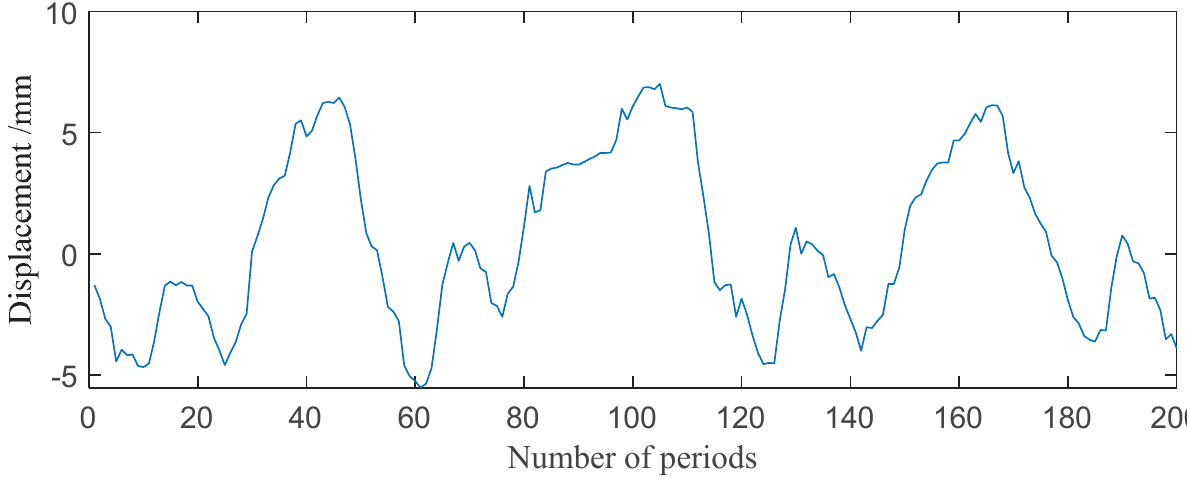
Figure 7. Horizontal displacement sequence of dam.